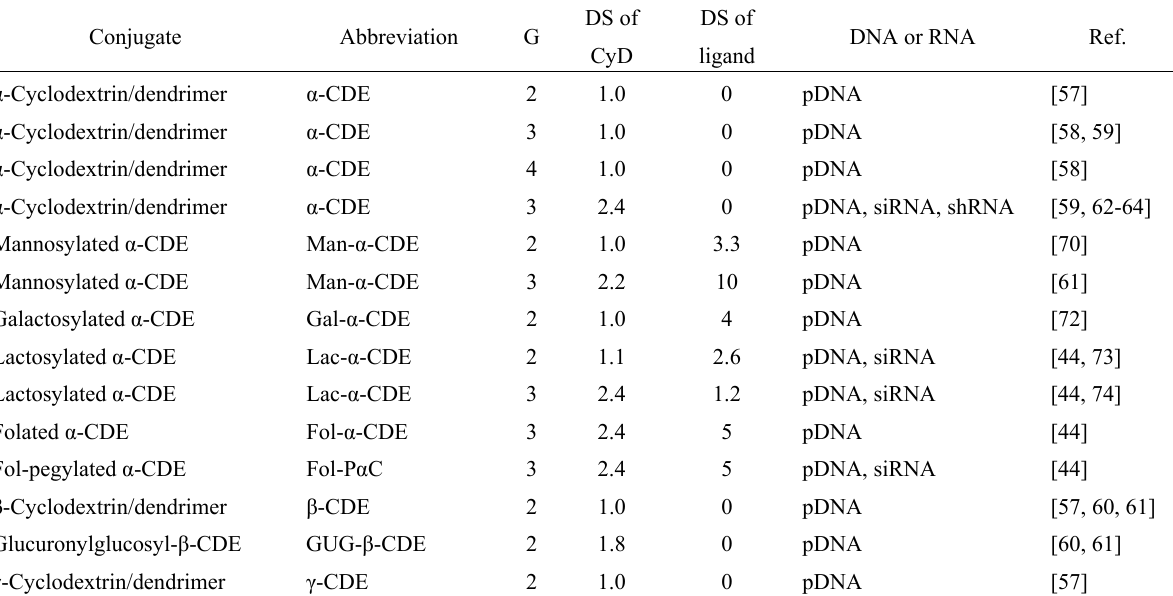
Table 1. Cyclodextrin/dendrimer conjugates described in this